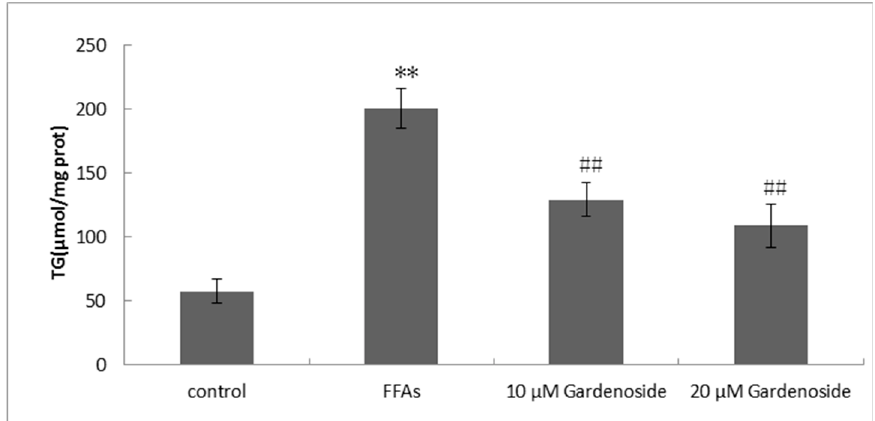
Figure 3. Effect of Gardenoside on triacylglycerol accumulation in FFAs induced hepatic steatosis in HepG2 cells. The Triglyceride (TG) level of the cells was measured by using TG assay kit. All experiments were repeated at least three times. ** p < 0.01, compared to control group, and ## p < 0.01, compared to FFAs group.